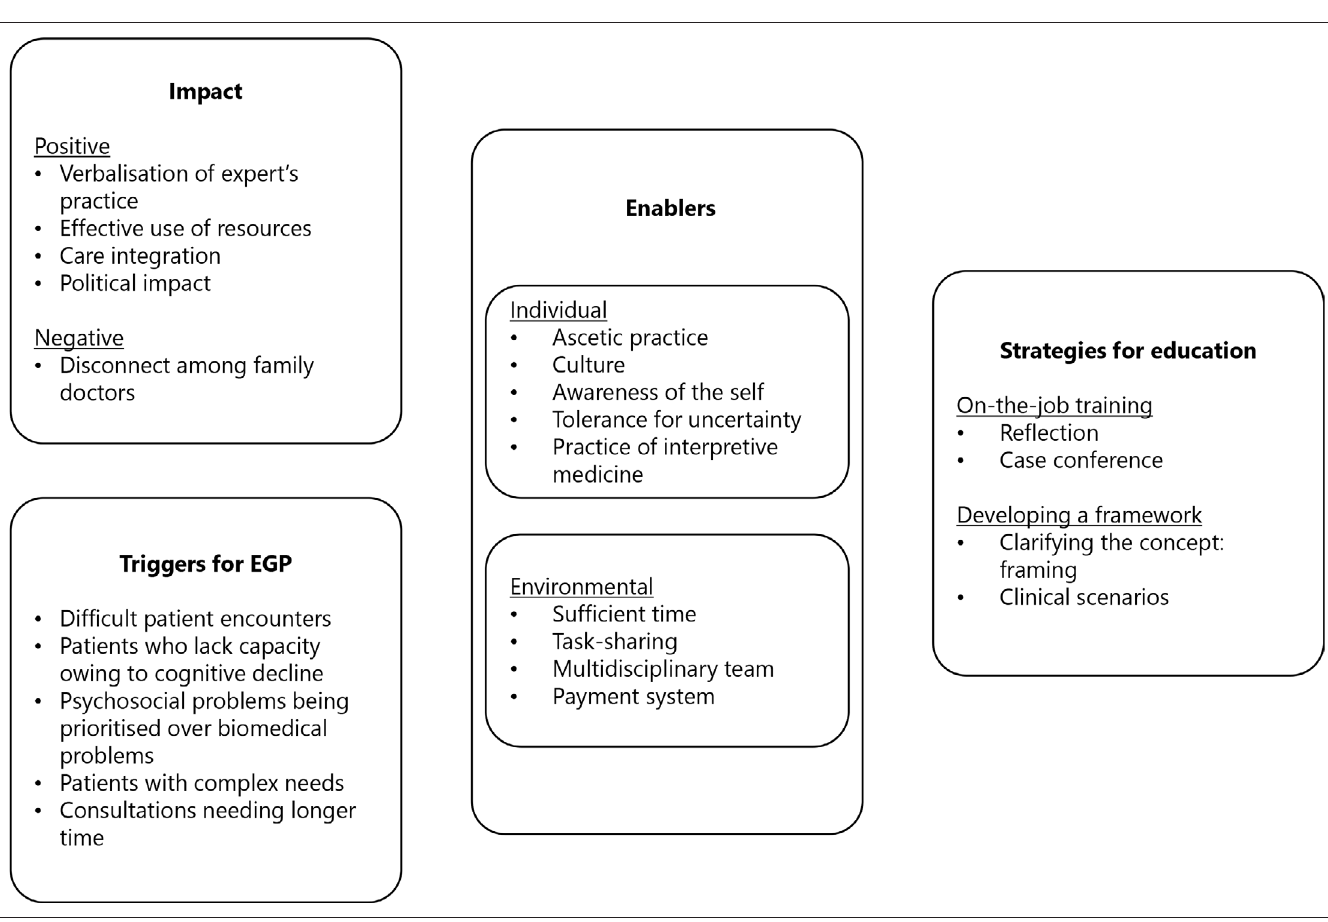
Figure 1 Japanese family doctors’ perspectives on expert generalist practice